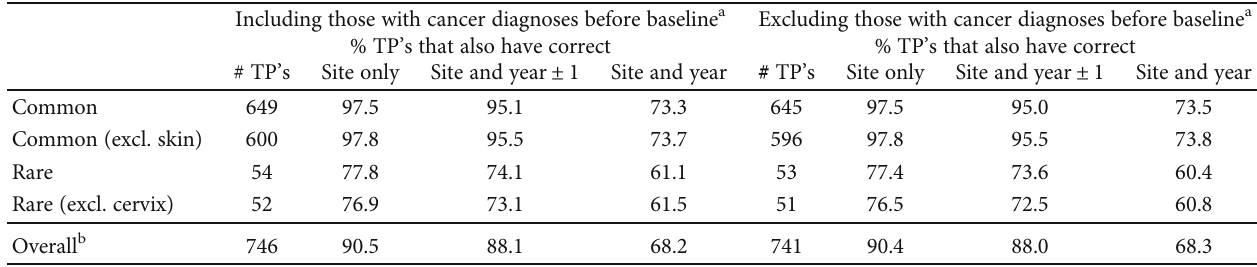
Table 3: Self-reported cancer site and year of diagnosis accuracy among ATP participants who correctly report overall, common, and rare cancer